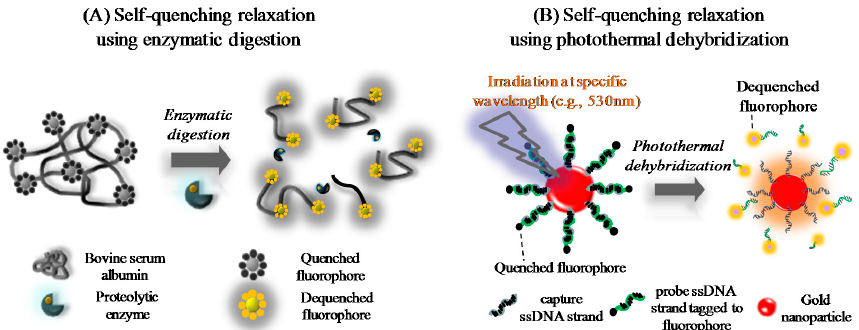
Figure 1. Signal generation from carrier-bound fluorescent dye molecules by reduction of the quenching phenomenon. Use of dye molecules heavily coupled with a carrier protein (e.g., BSA) resulted in relaxation of self-quenching at the time of signal generation by protease digestion ( A ). Nanoparticles can also be used as carriers by linking via DNA hybridization. Upon excitation, the fluorophore excitation energy is transferred to the surface of the plasmonic metal. This quenching may be relaxed generation ( B ).